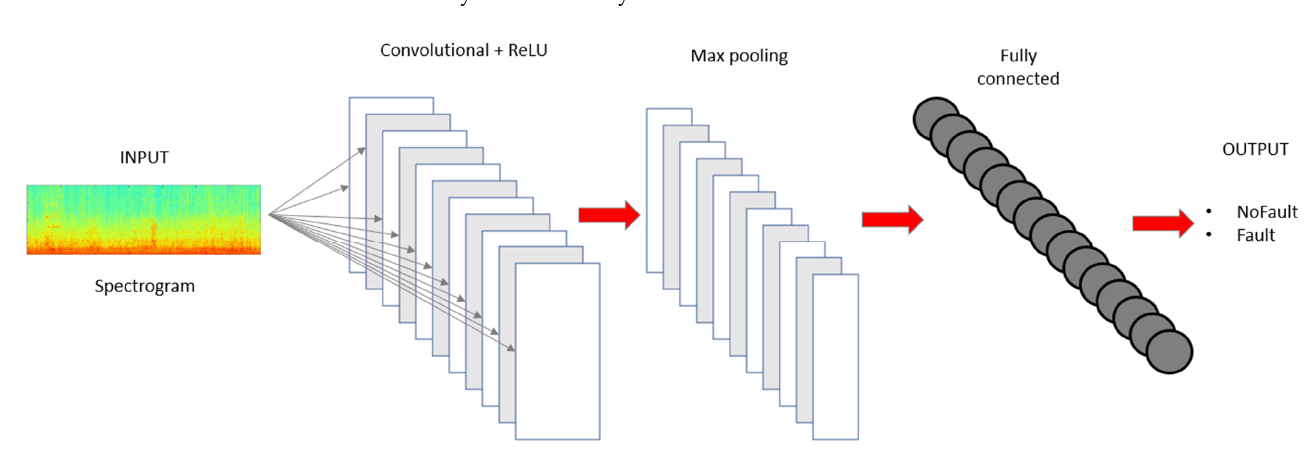
Figure 4. CNN architecture for classification.